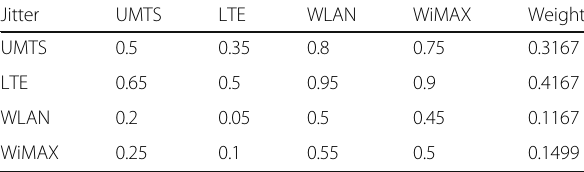
Table 13 Fuzzy consistent matrix and weights for jitter Jitter